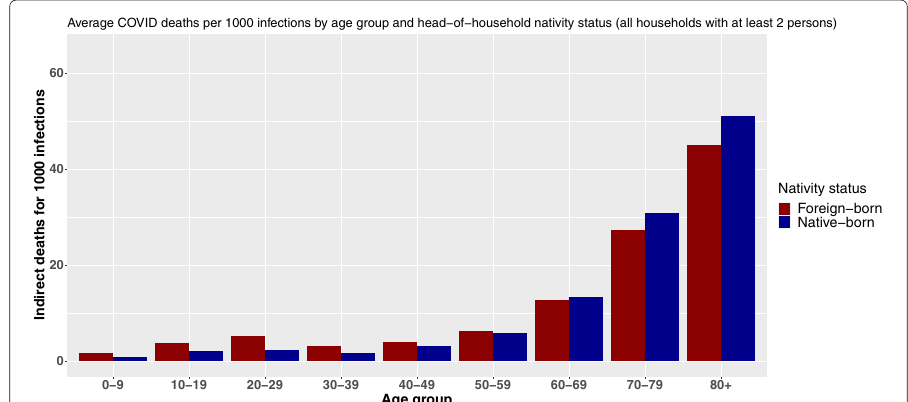
Fig. 10 Average COVID-19 deaths per 1000 infections by age group and head-of-household nativity status (2+ members)